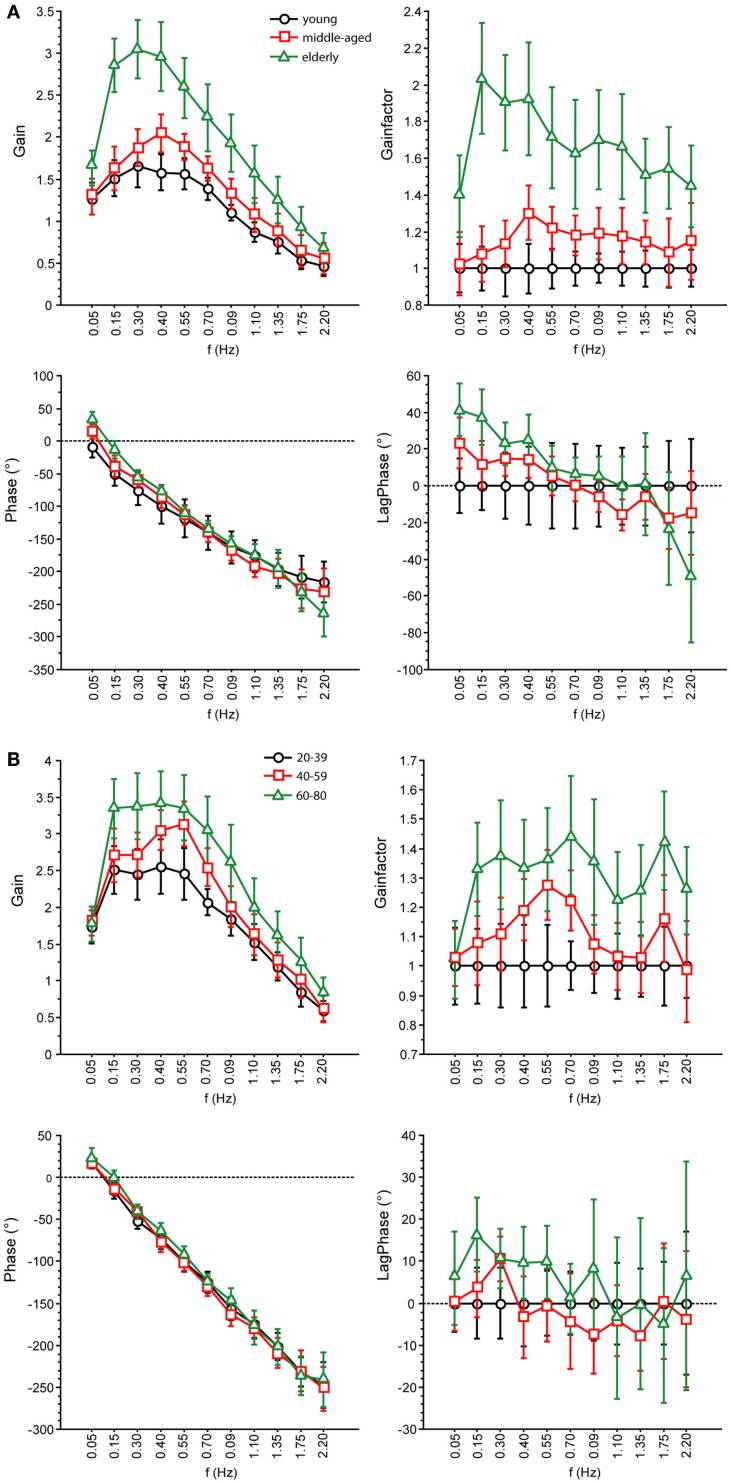
Parameters of perturbed stance. GAIN, GAINFACTOR, PHASE, LAGPHASE of the three age groups at 1° with eyes open (A) and eyes closed (B).